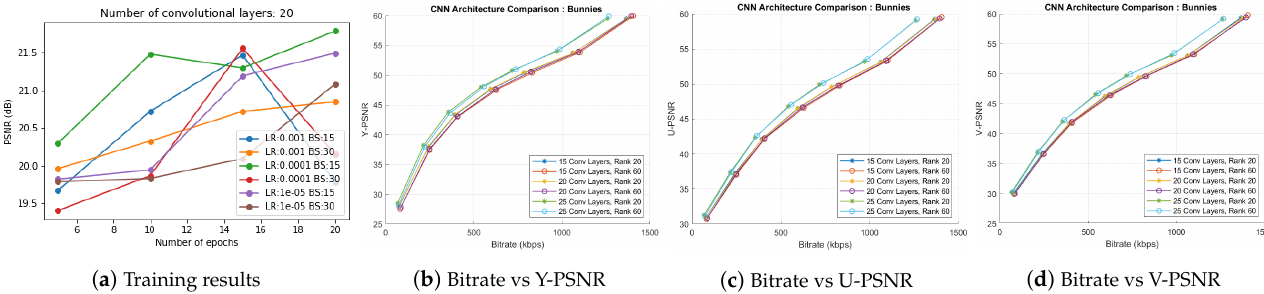
Figure 8. ( a ) Training results of the CNN with 20 convolutional layers. Optimal PSNR is observed for model run for 20 epochs with learning rate 0.0001 and batch size 15; ( b – d ) rate-distortion curves comparing results of CNN structures with 15, 20, and 25 convolutional layers trained for 20 epochs with learning rate 0.0001 and batch size